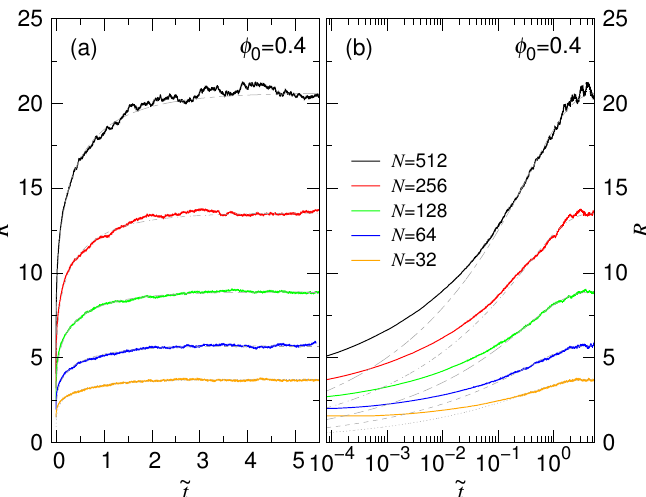
Figure 9. Fitting chain expansion in the second stage for φ 0 = 0.4. The scaled time ˜ t = t / τ c is used to make the plot. Panel ( a ) is plotted in linear scale of ˜ t while Panel ( b ) is plotted in logarithmic scale. The chain length can be read in the